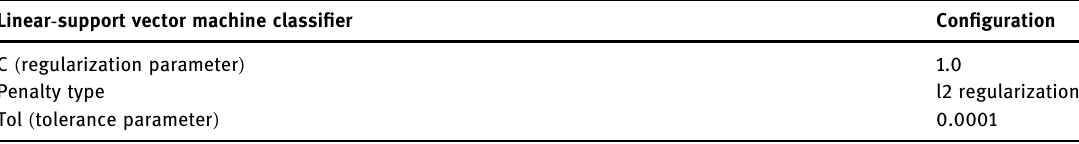
Table 1: Tuned hyperparameters for linear support vector machine classi fi er Linear - support vector machine classi fi er